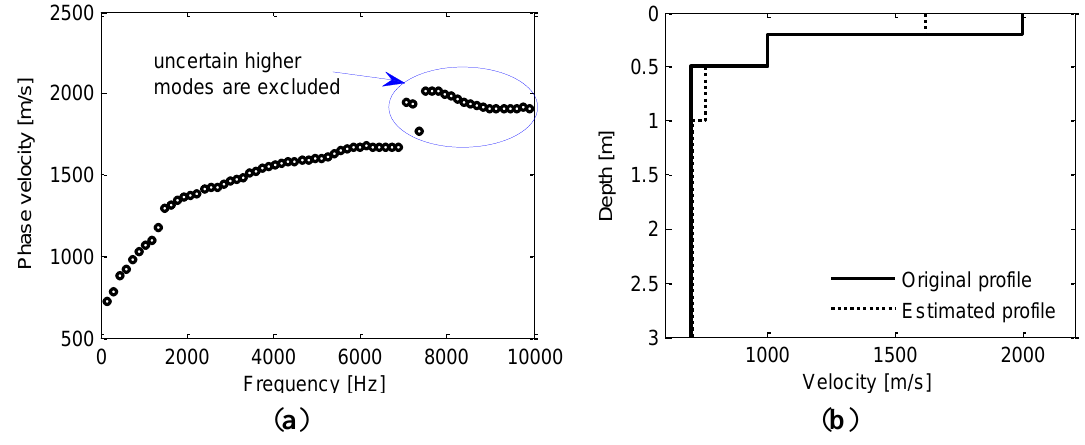
Figure 10. Inverted shear velocity profile vs. original profile for descending stiffness profile; ( a ) Analytical dispersion curve; and ( b ) Inverted averaged shear